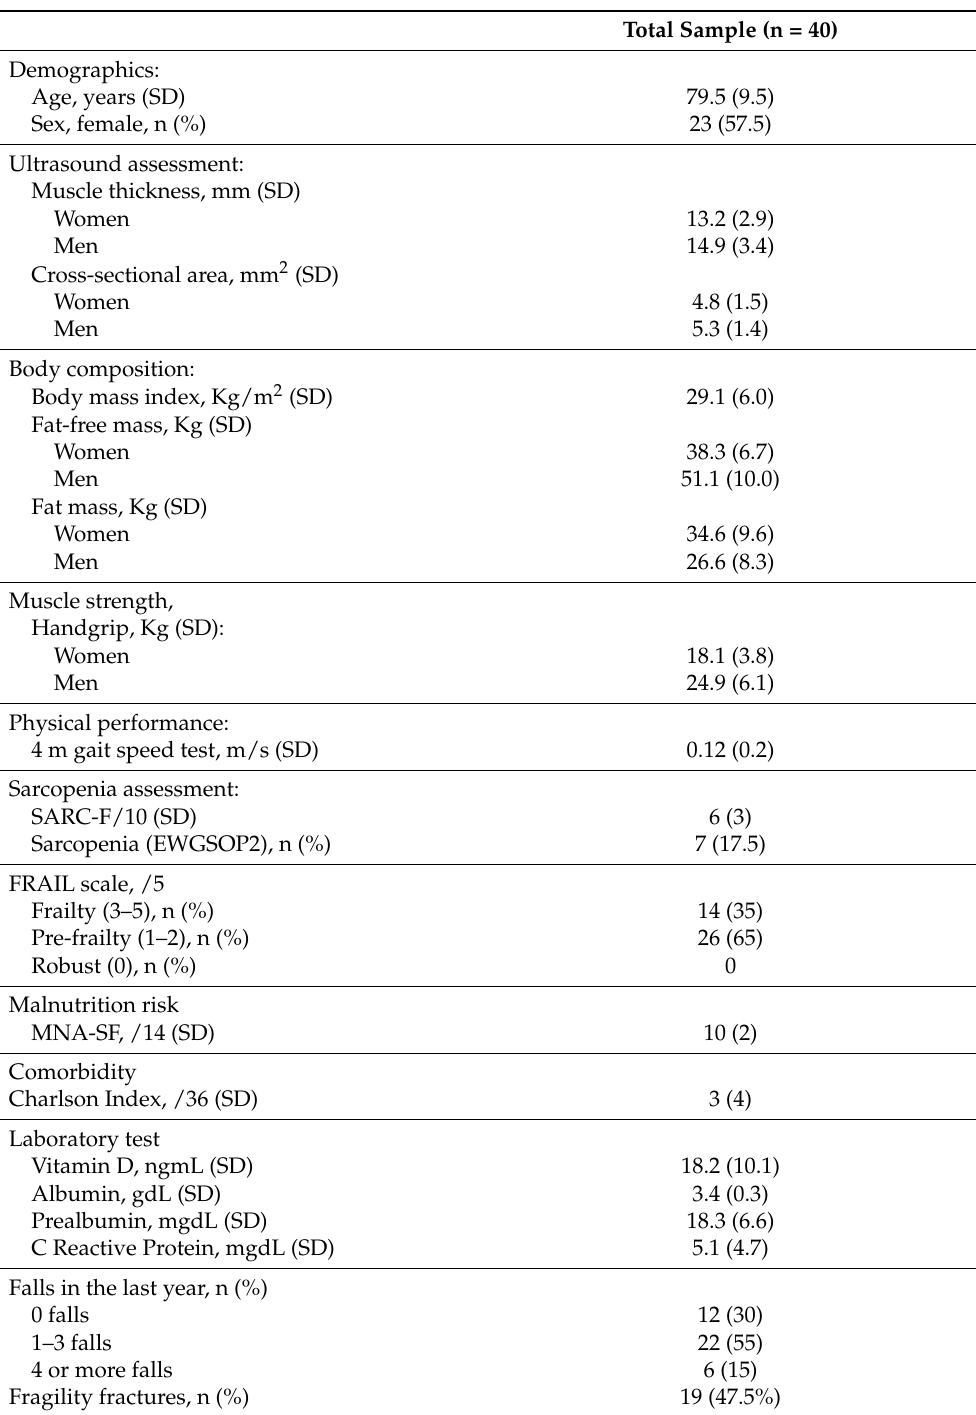
Table 2. Baseline demographic and clinical characteristics of study participants at admission to the post-acute care